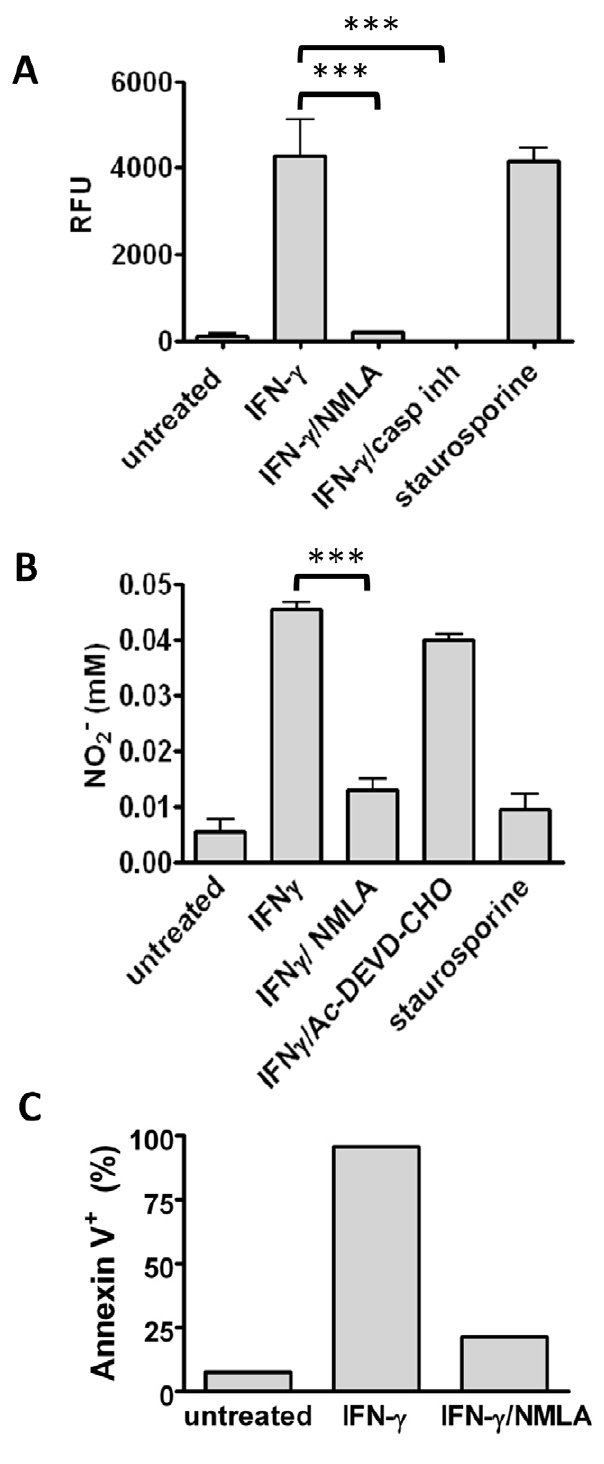
Figure 3. IFN- c induces apoptosis in BMM W in an NO- dependent manner. Resting or IFN- c activated (2000 U/ml O/N) BMM W were infected with BCG (MOI 10, A and B) or M. tuberculosis (MOI 1, C) for 1 h, and subsequently treated with NMLA (1 mM), caspase 3/7 inhibitor (Ac-DEVD-CHO, 100 m M; Z-VAD, 20 m M), or staurosporine (1 m M). A) Caspase 3/7 activity 48 h p.i. with BCG is shown as